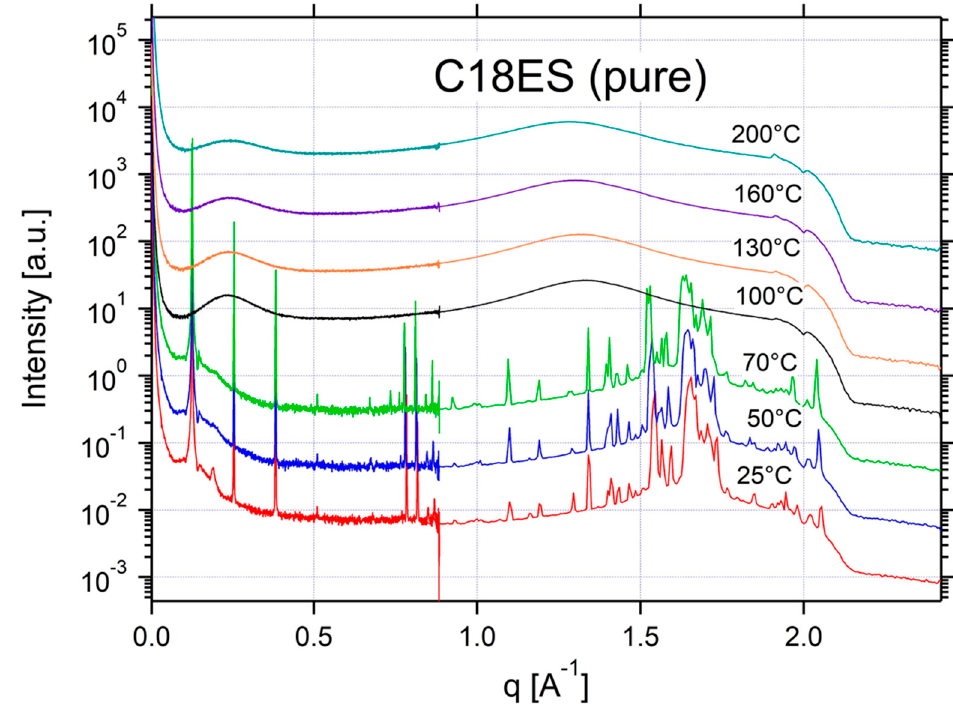
Figure A15. SAXS and WAXS data for pure C18ES.